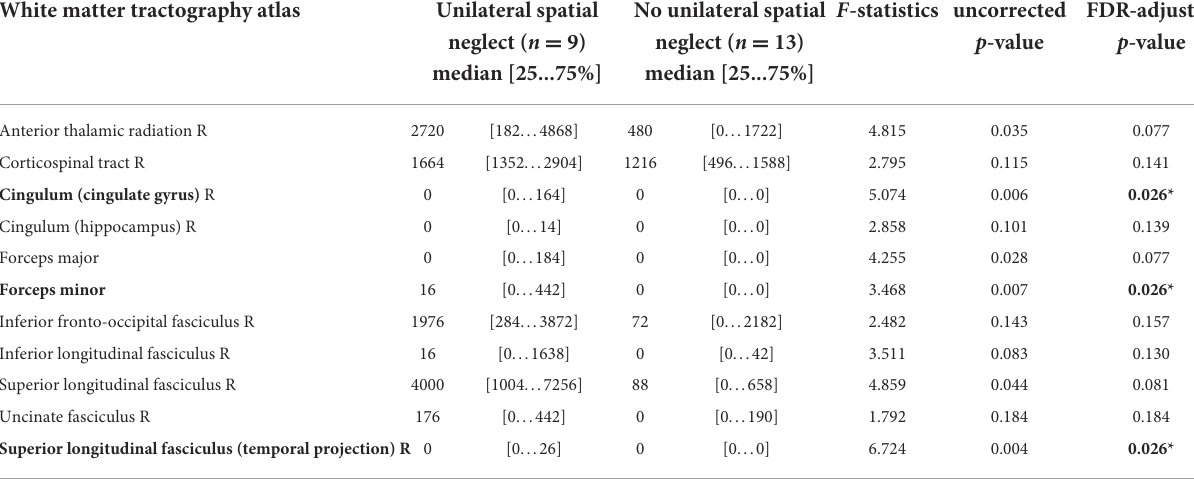
TABLE 2 Overlap (mm 3 ) of the lesions in each group with the major white matter tracts. White matter tractography